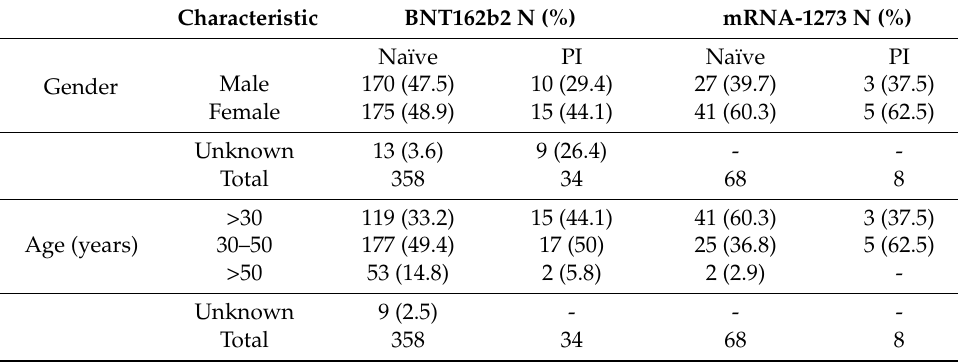
Table 1. Demographic characteristics of the study sample ( n =